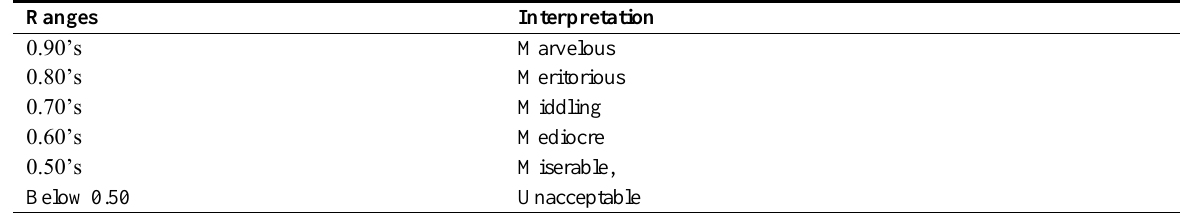
Table 2: Kaiser-Meyer-Olkin (KMO) test Interpretation Range